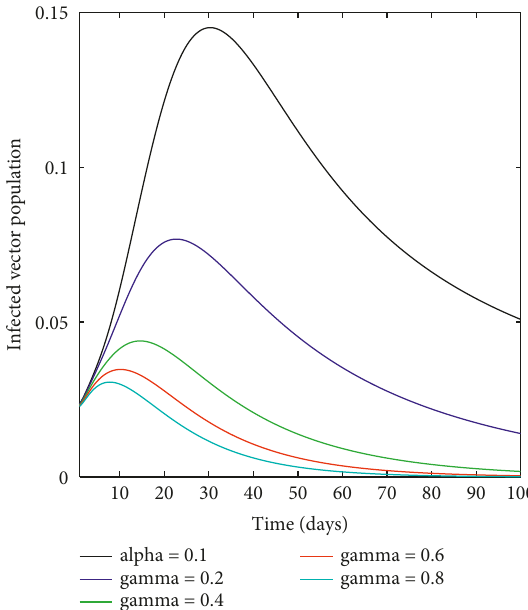
Figure 17: Increasing recovery rate with α � 0.6.